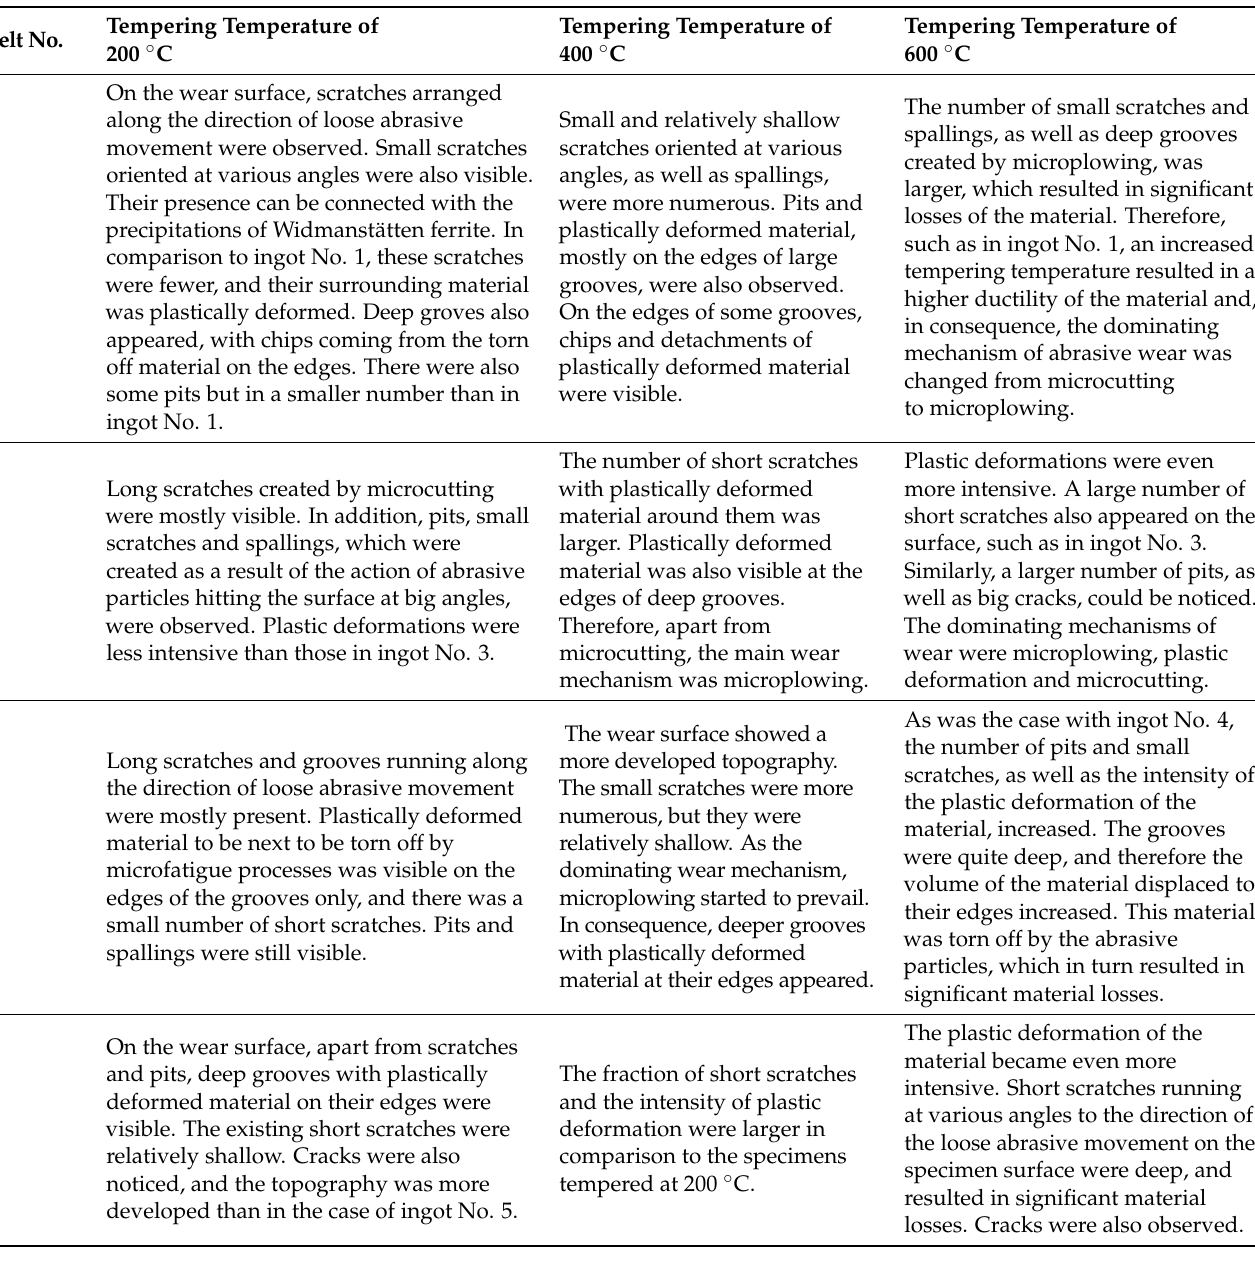
Table 3. Wear mechanisms of ingots No. 2, 4, 5, 6, 7 and 8 at different tempering